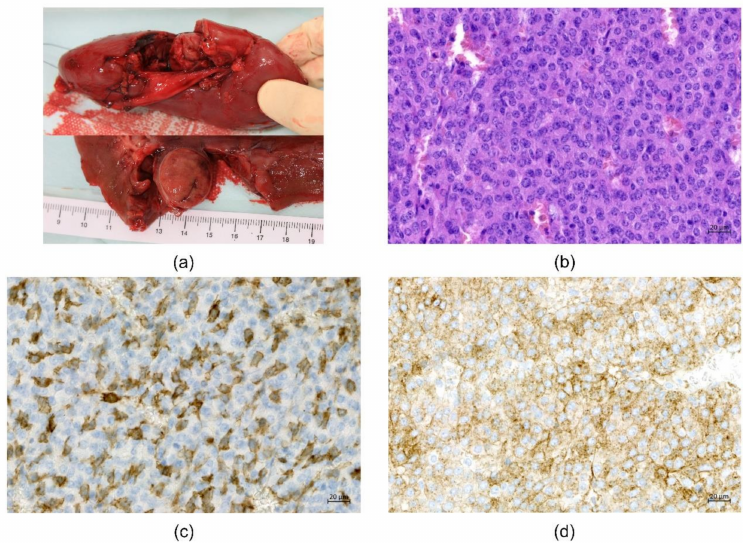
Figure 3. Examination of the tumor. ( a ) Gross examination. Spherical solid pinkish tumor located at the renal hilum (size 25 × 20 × 20 mm). ( b ) Microscopic examination. Monotonous population of polygonal cells with a fine granular cytoplasm and round nuclei in solid sheets and trabeculae. Hematoxylin–eosin staining, magnification 200 × . ( c ) Immunohistochemical examination. Positive immunostaining for CD 117, magnification 200 × . ( d ) Immunohistochemical examination. Positive immunostaining for CD34, magnification 200 ×